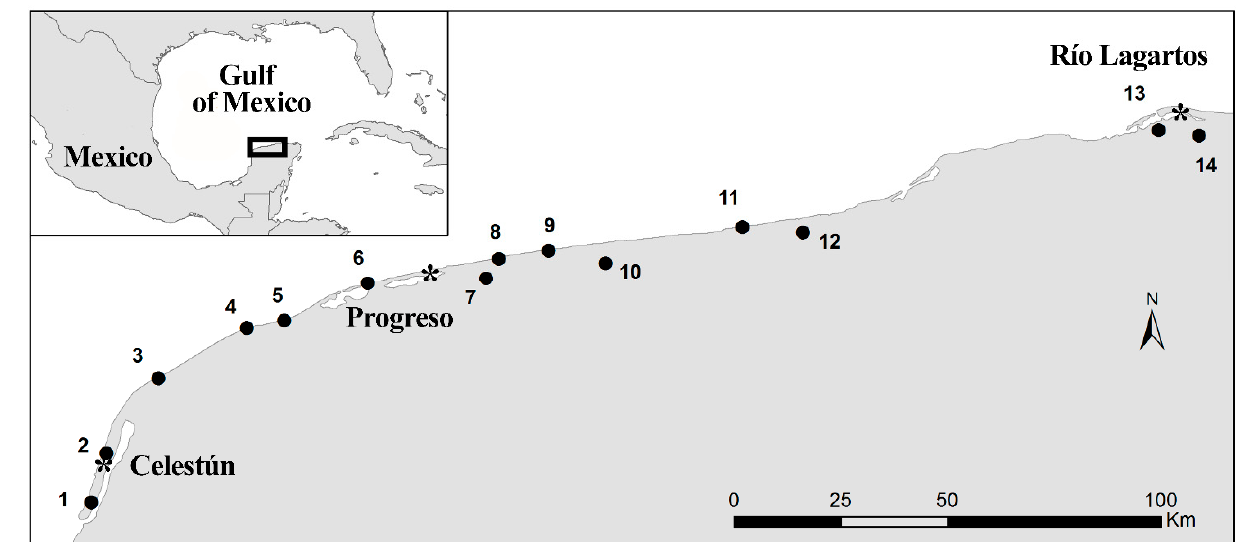
Figure 1. Sampled sites in the northwest and central tip of the Yucatan Peninsula, Mexico to study the genetic diversity of Campylorhynchus yucatanicus populations in the field between 2015 and 2016: (1) southwest Celestún, (2) northeast Celestún, (3) El Palmar, (4) west Sisal, (5) east Sisal, (6) Chuburná, (7) Capilla, (8) west Chixchulub, (9) San Benito, (10) Xcambó, (11) Santa Clara, (12) Dzilam, (13) west Ría Lagartos, and (14) east Ría Lagartos. We locate the main coastal cities (*).